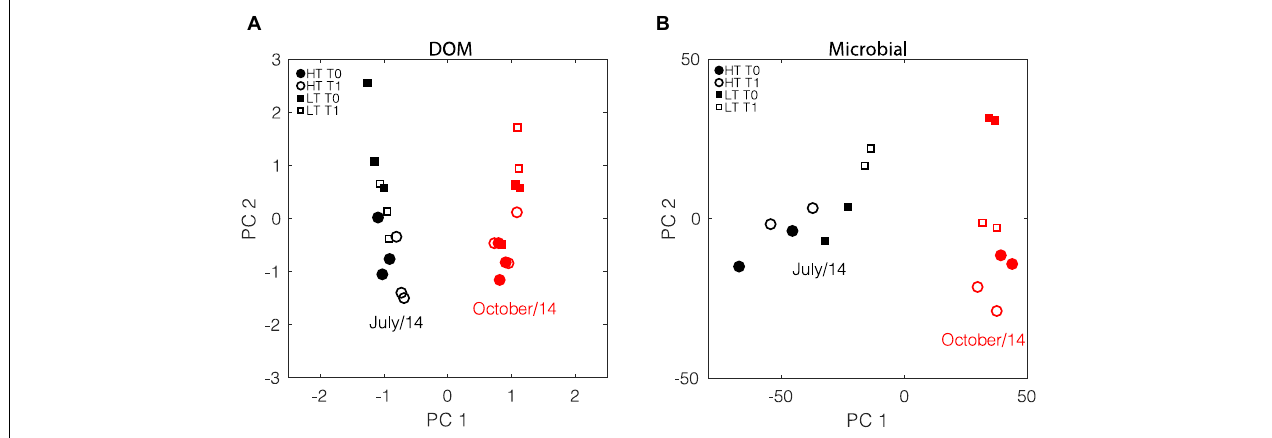
FIGURE 5 | Comparison of patterns of variability between chemical and microbial data. Black and red symbols represent July and October, respectively. Solid and open symbols represent T0 and T1, respectively. Circle and square symbols represent high tide and low tide, respectively. (A) PCA scores of DOM composition. The first and second principal components explained 32% and 9% of the variance. (B) Corresponding PCA scores for gene expression data. The first and second principal components explained 66% and 13% of the variance.